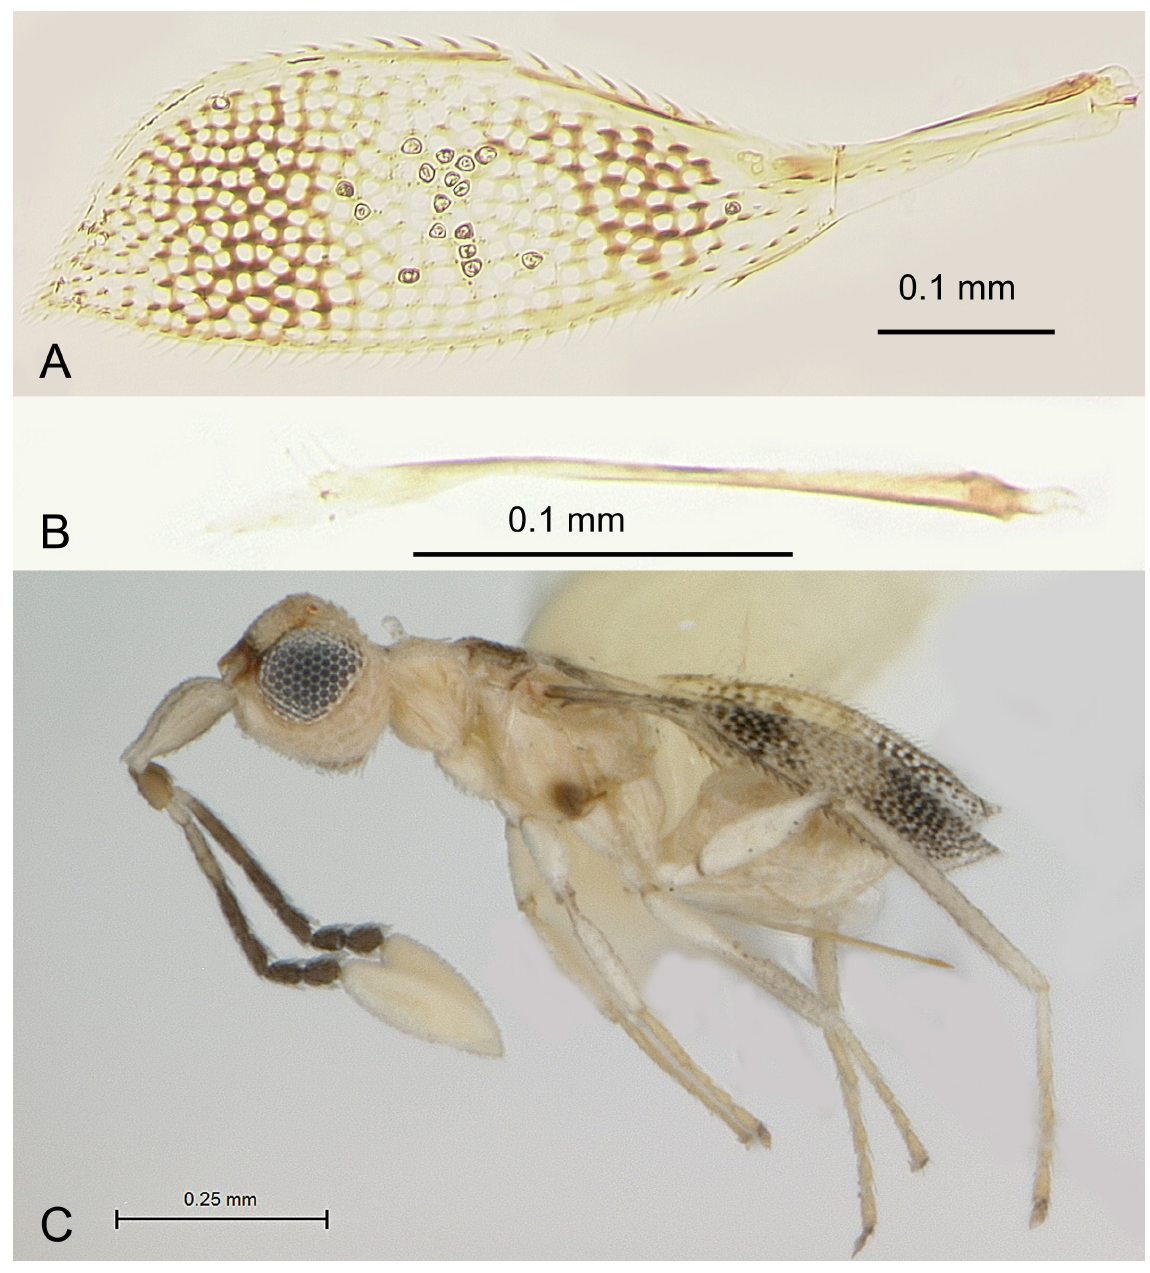
Fig. 9. Ganomymar libertatium sp. nov., ♀, holotype (CAS). A . Fore wing. B . Hind wing. C . Habitus in lateral view (prior to